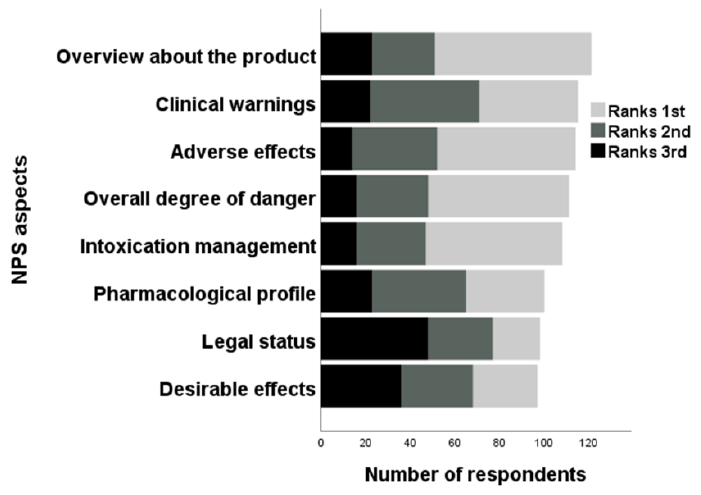
Figure 6. Ranking of various NPS aspects fundamental for improvement.